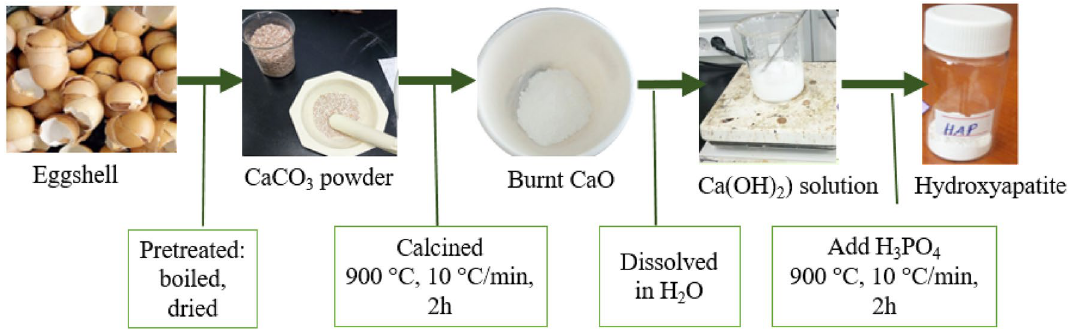
Figure 1. Synthesis steps of HAp from the